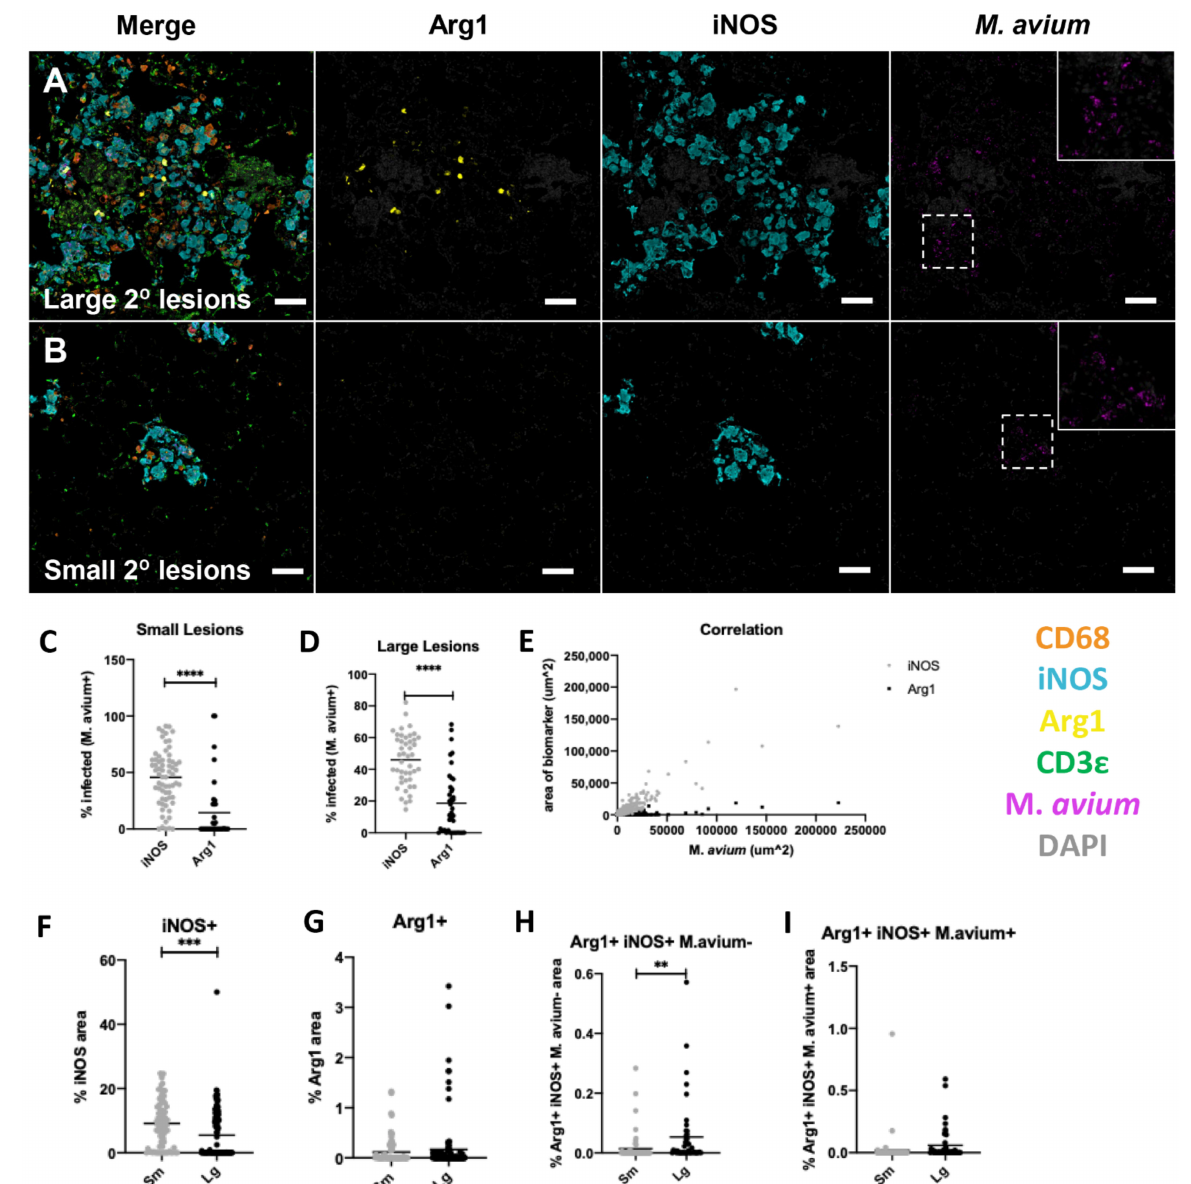
Figure 4. Characterization of macrophage populations in large and small secondary lesions at 16 weeks post-infection (wpi) following unilateral left mainstream intrabronchial M. avium inoculation in B6.Sst1S mice. ( A , B ) representative raw fluorescent multiplex immunohistochemical (fmIHC) image of large secondary lesions ( A - top row ), and small secondary lesion ( B - lower row ), with all filters turned on, or only Arg1, iNOS, or M. avium individually ( C ) percentage antigen overlay of M. avium + area with iNOS+ and Arg1+ in small lesions; ( D ) percentage antigen overlay of M. avium + area with iNOS+ and Arg1+ in large lesions; ( E ) correlation between M. avium area on x -axis and iNOS or Arg1 area on y -axis; ( F – I ) AQ of iNOS, Arg1, and M. avium overlay in small and large granulomatous lesions; ( F ) iNOS AQ; ( G ) Arg1 AQ; ( H ) Arg1+/iNOS+/ M. avium − AQ; ( I ) Arg1+/iNOS+/ M. avium + AQ. For ( C – I ), each data point represents a single lesion. For ( C ), n = 66 (iNOS), n = 36 (Arg1); for ( D ), n = 45 (iNOS), n = 40 (Arg1); for ( E ), n = 883; for ( F – I ), n = 67 (large lesions), n = 45 (small lesions). Data are expressed on scatter dot plots with medians. Asterisks denote p -values with Student’s unpaired t -test. ** p < 0.005, *** p < 0.0005, and **** p < 0.00005. Original magnification 100 × 200 × 100 × ( A , B ). Scale bars: 50 µ m ( A , B